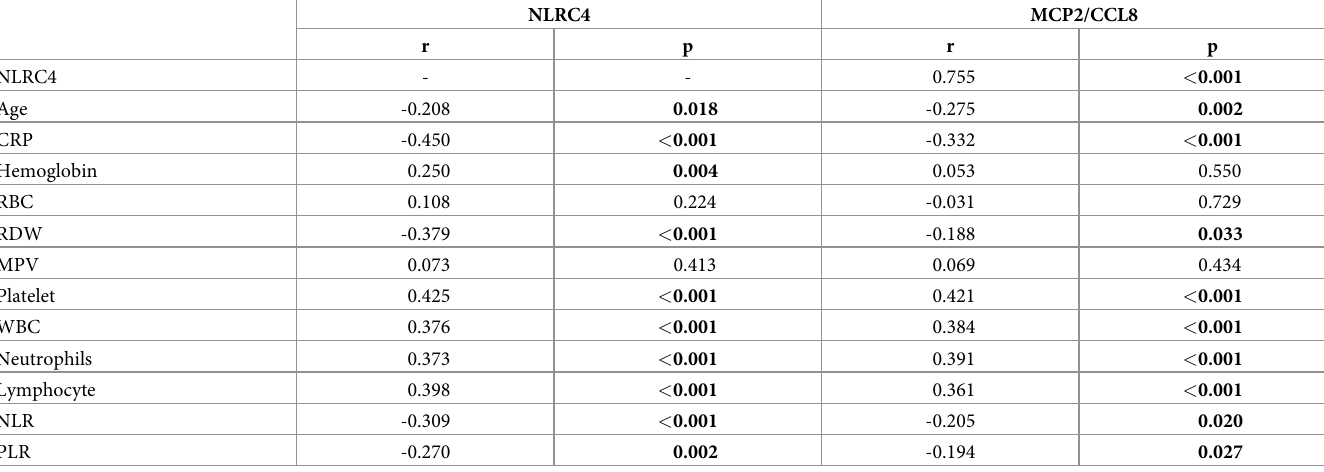
Table 2. Correlation between NLRC4 and MCP2/CCL8 levels and other parameters.